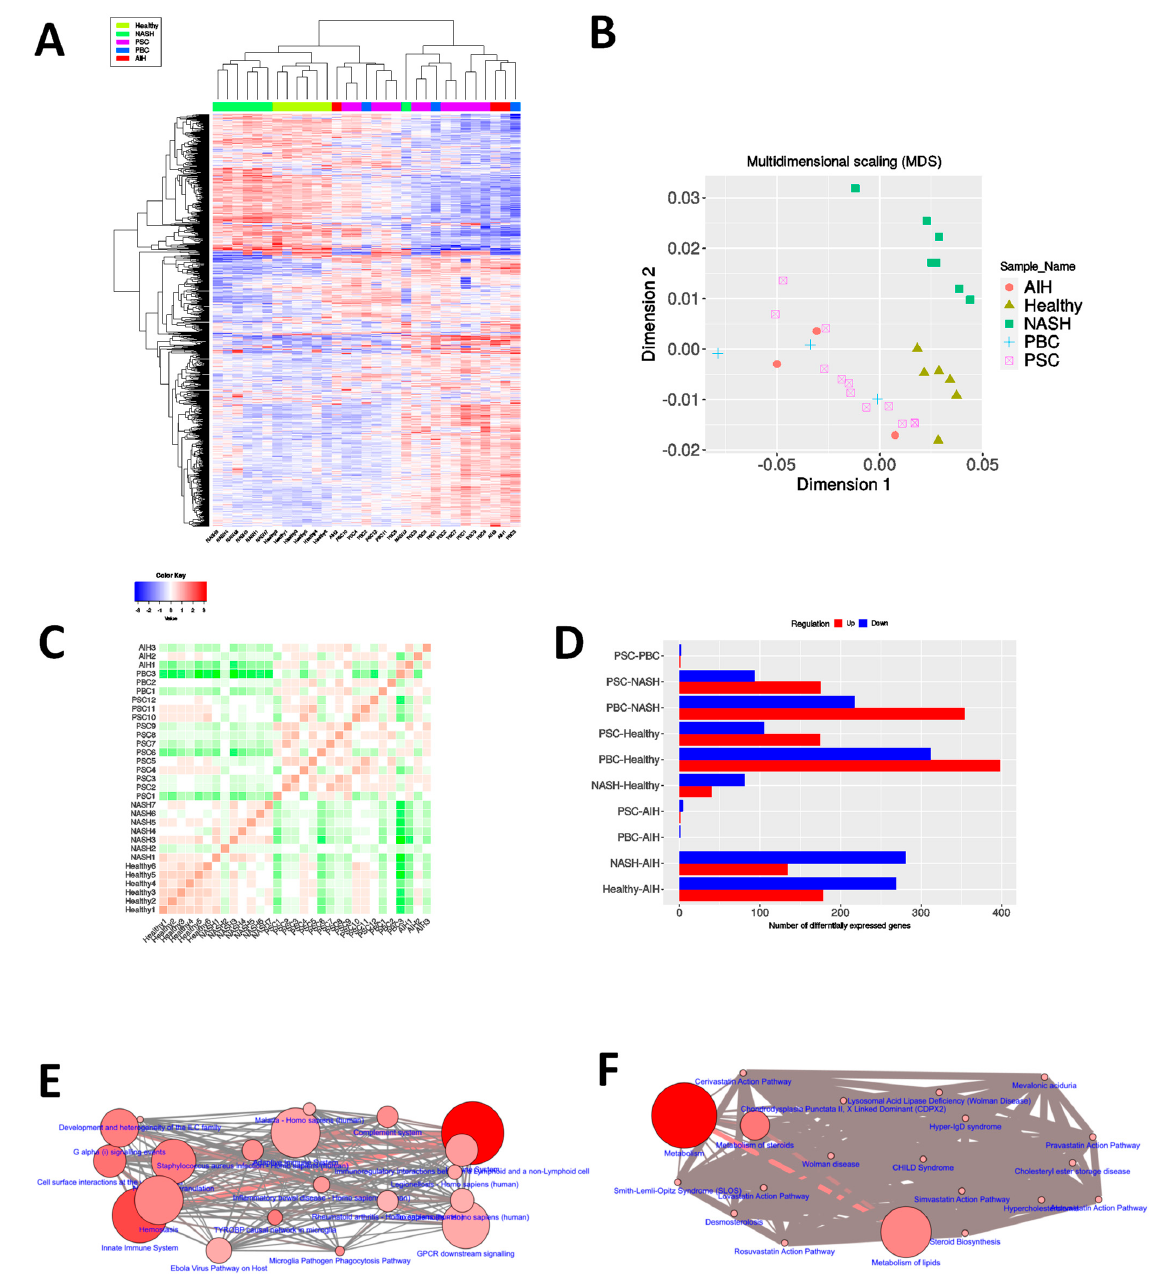
Figure 1. Different autoimmune liver diseases display overlapping transcriptomic signature. ( A ) gene expression heatmap showing hierarchical clustering of inflammatory liver disease samples from GSE159676. ( B ) MDS plot showing unsupervised clustering of inflammatory liver disease samples on a 2D plane. ( C ) correlation heatmap of inflammatory liver disease samples. ( D ) bar diagram showing number of differentially expressed genes (at the top of each bar) between each disease group ( E , F ) network of pathways exhibiting maximal enrichment with respect to genes upregulated ( E ) and downregulated ( F ) in all three autoimmune liver diseases, constructed on ConsensusPathDB.